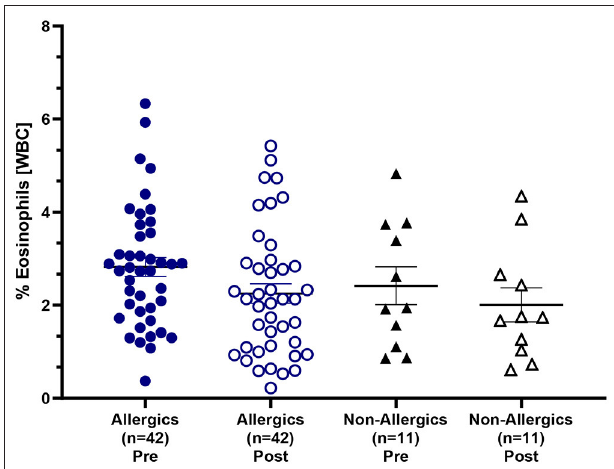
FIGURE 4 | Eosinophil counts as a percentage of white blood cells in the peripheral blood. Blood samples collected pre- and post-HDM exposure were evaluated for complete blood counts with differentials. Eosinophils were evaluated as a percentage of all white blood cells in the peripheral blood. Both allergic and non-allergic participants experienced a decrease in % eosinophils post-exposure compared to pre-exposure.